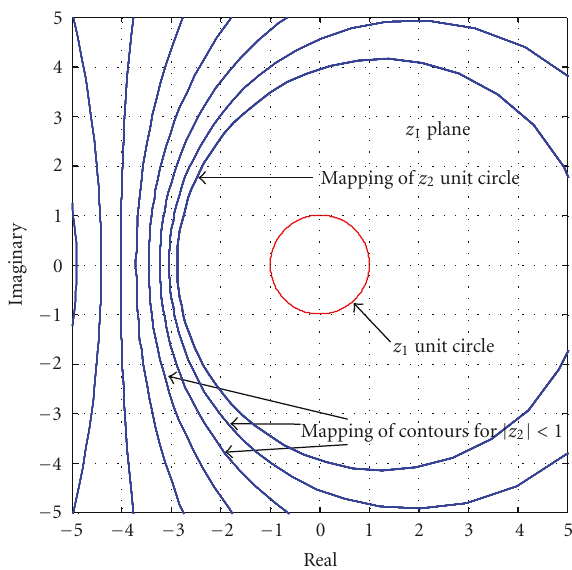
Figure 3: Mapping of z 2 unit circle onto z 1 plane for the unstable filter.